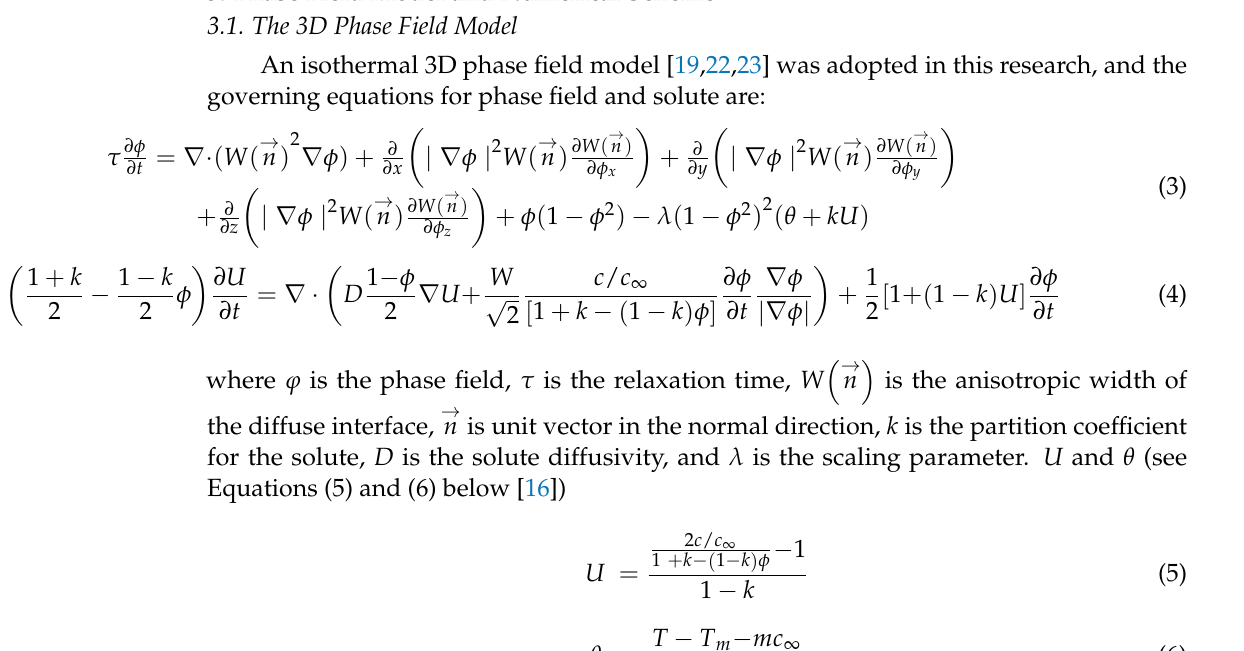
Figure 2. ( a ) A typical 2D projection selected from the synchrotron X-ray tomoscans containing multiple equiaxed dendrites. ( b – d ) The methods for processing the multiple dendrites from the raw images including cropping the subvolume V1, applying a 3D median filter, and thresholding. ( e , f ) The extractions of subvolume V2 (used for comparing with the results from phase filed simulation) and dendrites D1 and